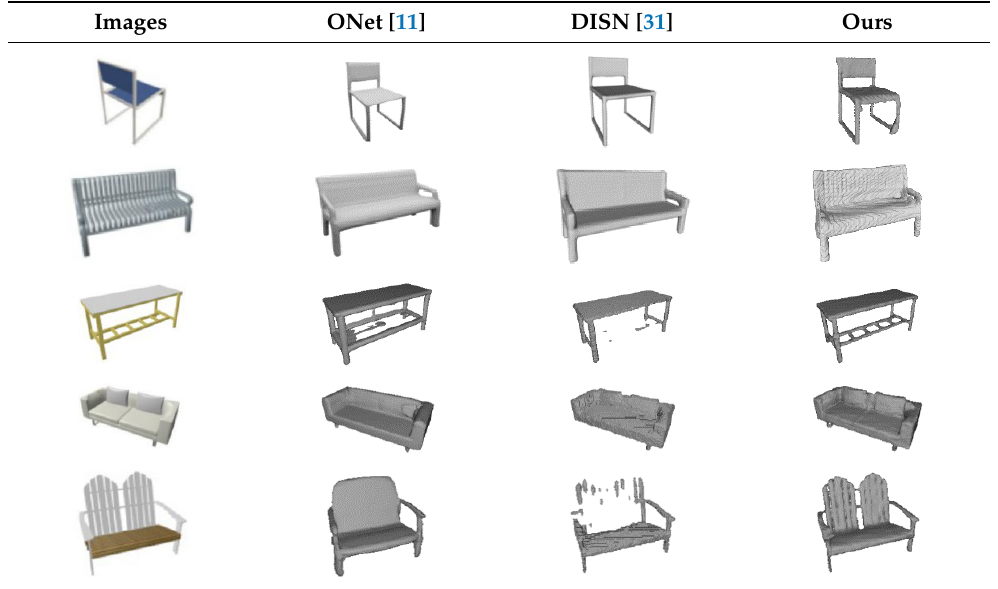
Table 2. Comparison of different algorithms for furniture reconstruction.